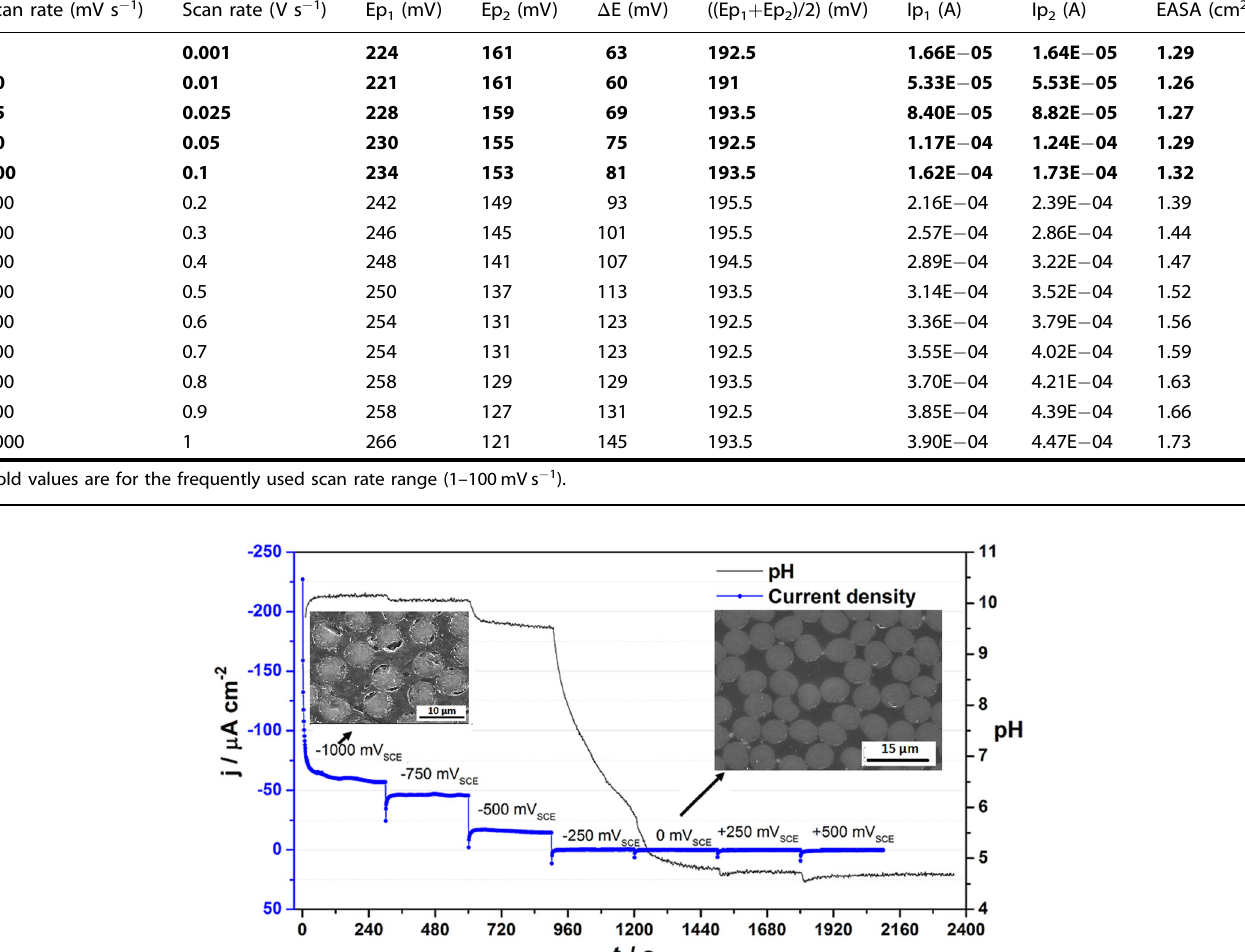
Table 1. Parameters from cyclic voltammograms in ferricyanide/ferrocyanide redox couple. Scan rate (mV s − 1 )